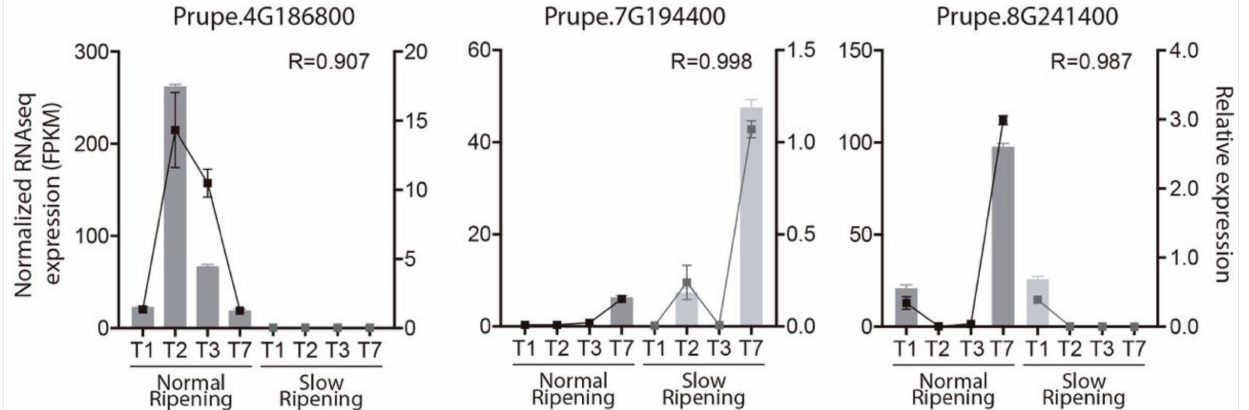
Figure 4. Validation of RNAseq results by qPCR. Comparison between normal and slow ripening expression profiles determined by RNAseq and qPCR of three differentially expressed candidate genes are displayed. The left axis represents the expression profile, in FPKM, of genes measured by RNAseq (bars). The right axis presents the relative expression profiles of genes measured by qPCR (lines). A Pearson correlation was calculated between the RNAseq and qPCR expression data and presented in each graph as the R